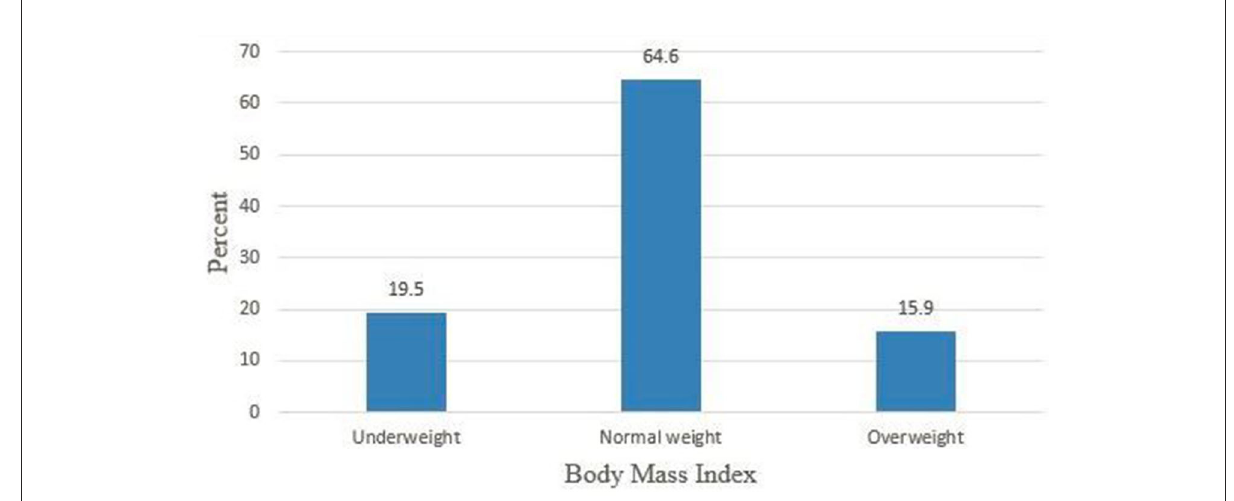
FIGURE2 Body mass index of female college students, Debre Berhan, Ethiopia, 2021 ( n =